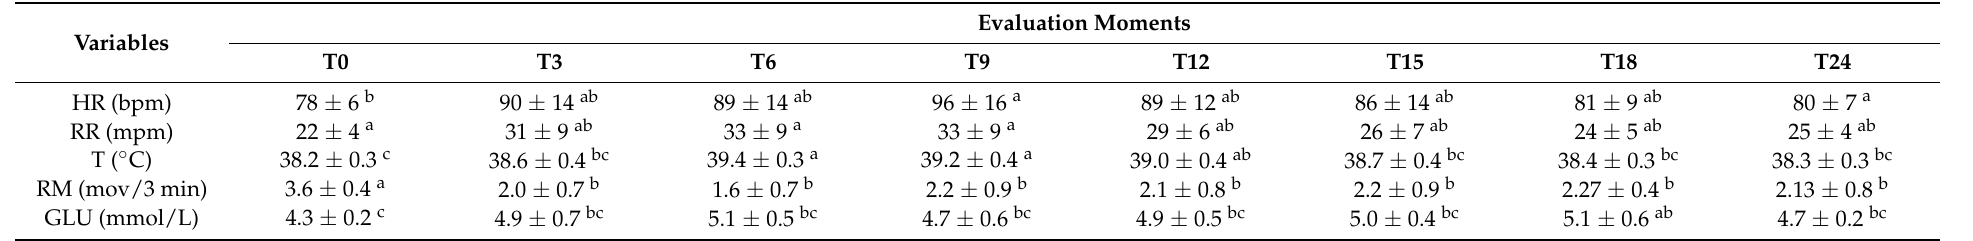
Table 4. Mean values and standard deviation of the heart rate (HR), respiratory rate (RR), temperature (T), ruminal movements (RM), and blood glucose of cattle subjected to subacute ruminal acidosis (SARA) induction with the use of citrus